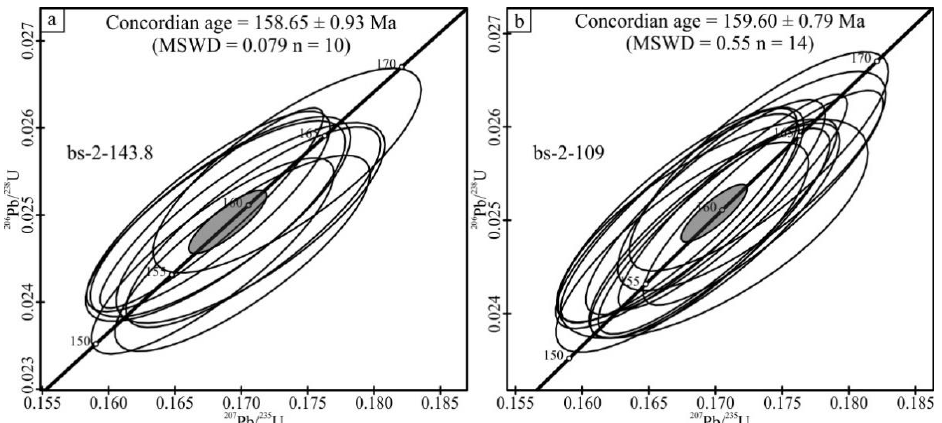
Figure 3. Concordia diagrams of LA-ICP-MS zircon U-Pb data for the monzonite ( a ) and monzonite- porphyry ( b ) of the Bystrinsky massif.